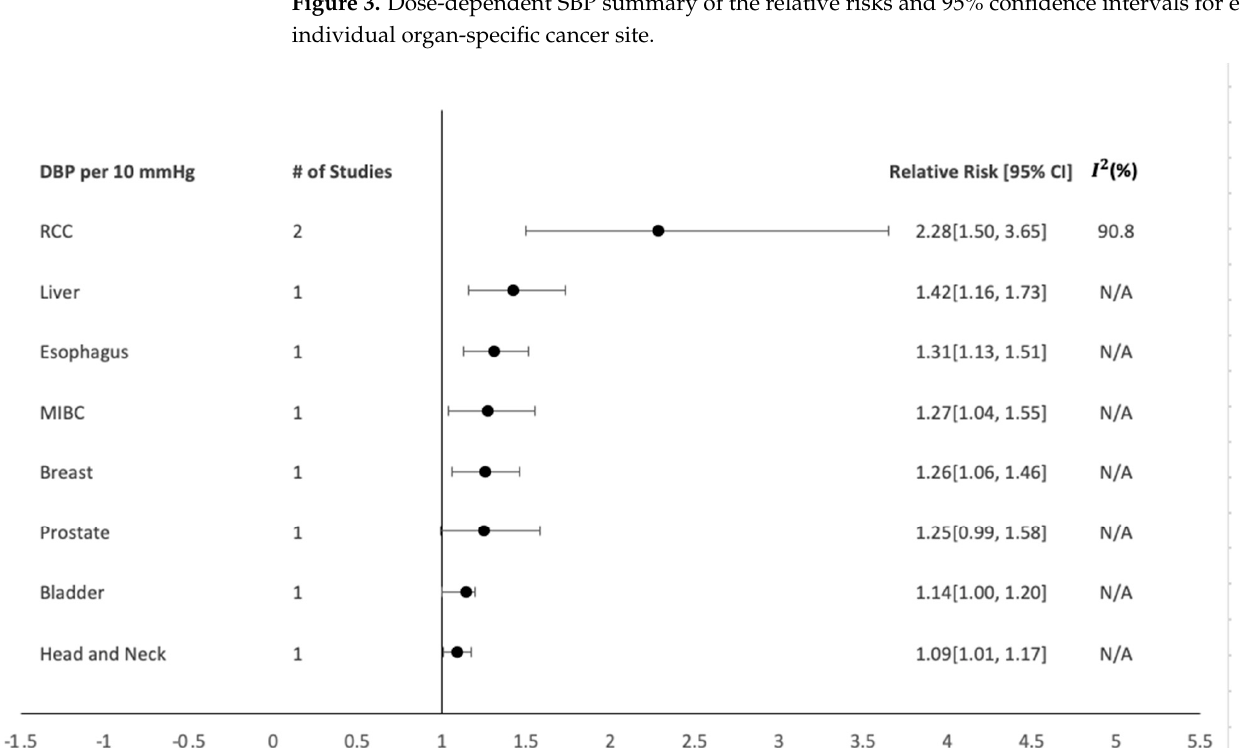
Figure 4. Dose-dependent DBP summary of the relative risks and 95% confidence intervals for each individual organ-specific cancer site.